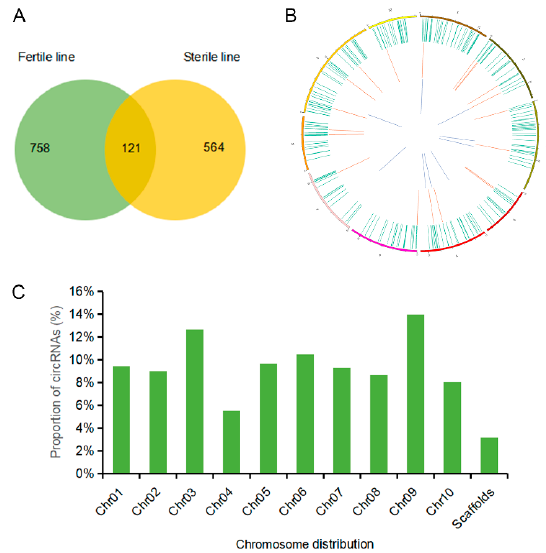
Figure 4. The circRNAs identified in Bcajh97-01B (fertile line) and Bcpol97-05A (sterile line) of Brassica campestris. ( A ) The number of circRNAs detected in the sterile line and fertile line. ( B ) Circos plot showing circRNAs on the chromosomes of B. campestris. The outmost layer of the ring is the chromosome map of B. campestris. The larger inner green ring represents all of the circRNAs detected by RNA-seq. The smaller red ring indicates the differentially expressed circRNAs with up regulation, and the innermost blue layer stands for the down-regulated circRNAs with fold change ≥ 2 and false discovery rate (FDR) <0.05. ( C ) Histogram of the distribution of circRNAs on the chromosome.